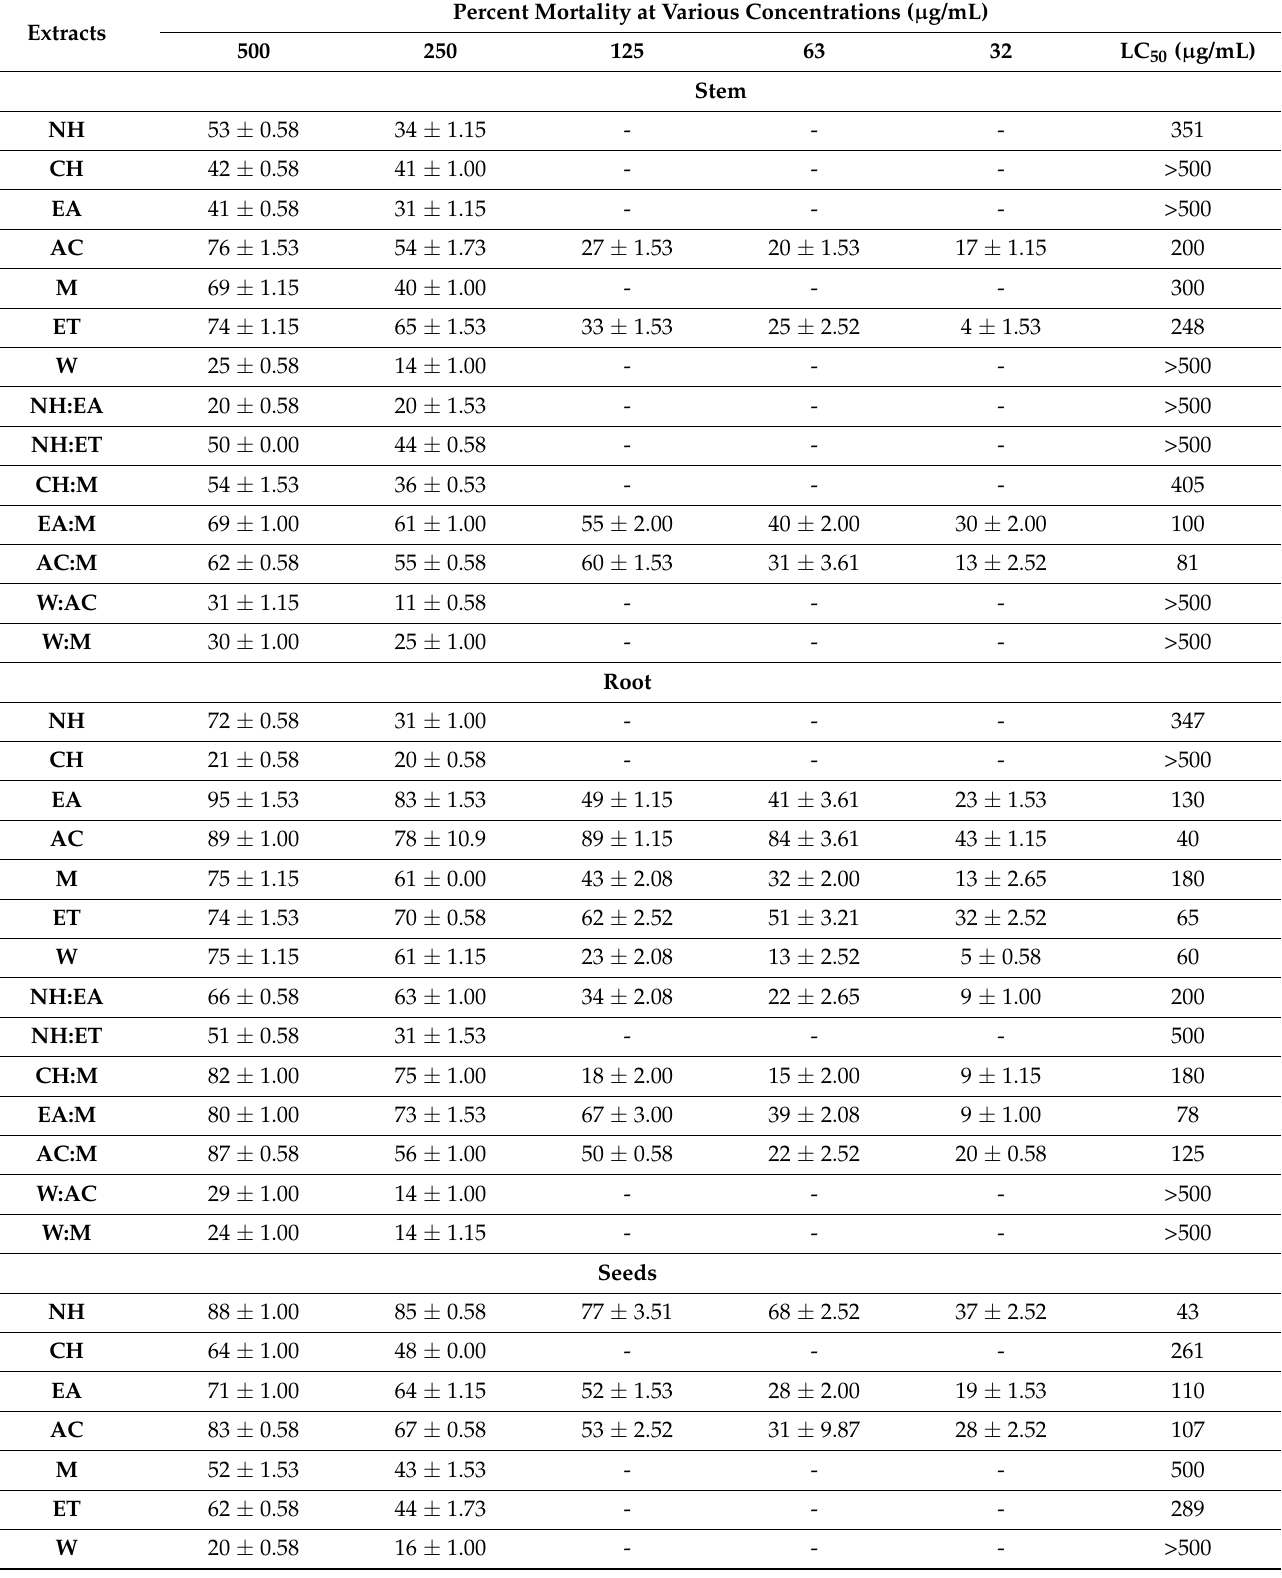
Table 5. Brine shrimp lethality assay of various solvent extracts of stem, root, seeds, and leaves of P. glabrum